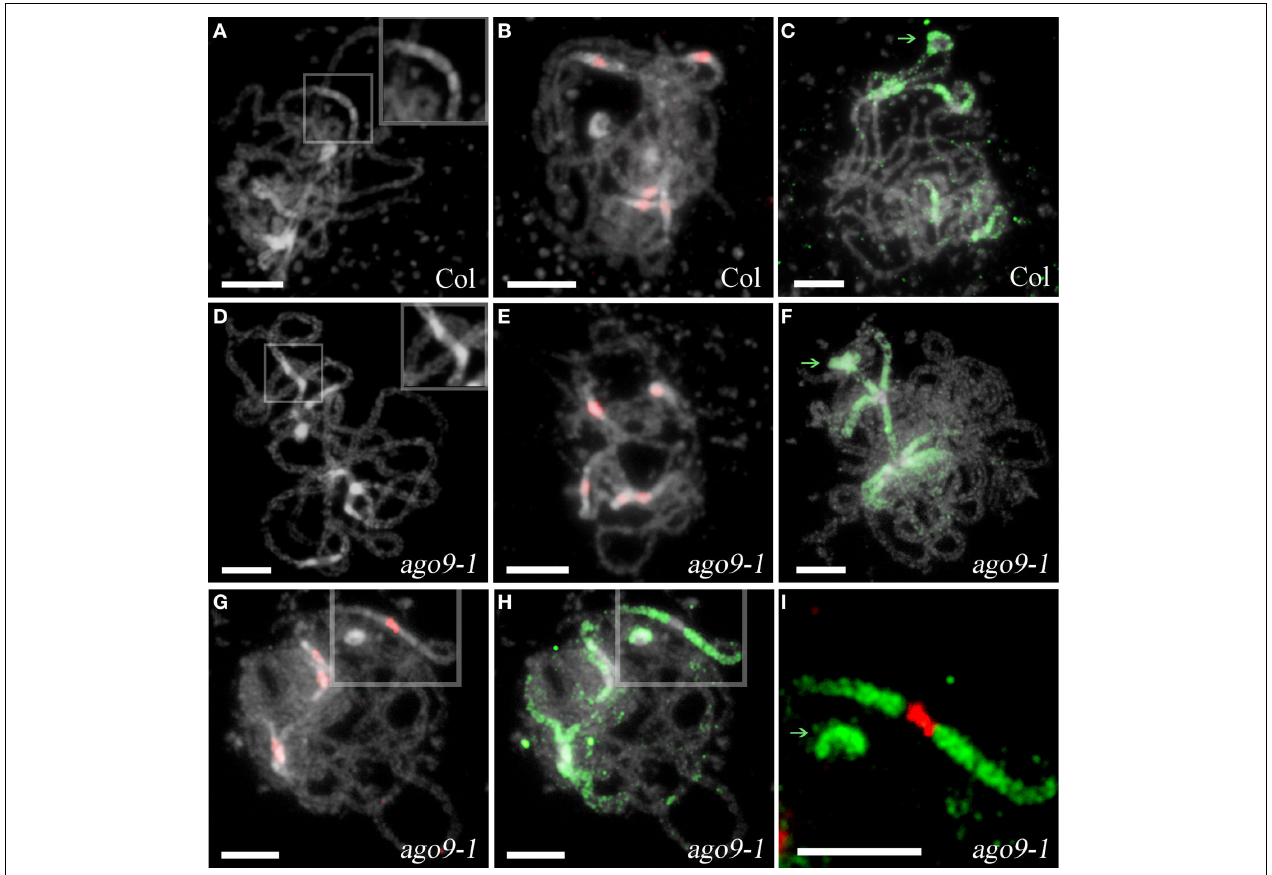
FIGURE 3 | Analysis of heterochromatic pericentromeric regions at pachytene in ago9-1 . (A,D) Pericentromeric regions are distinctly defined at Col and ago9-1 pachytenes. A detail of these regions is showed at the right top of each picture. (B,E) Detection of centromeric regions (using pAL1 as probe,